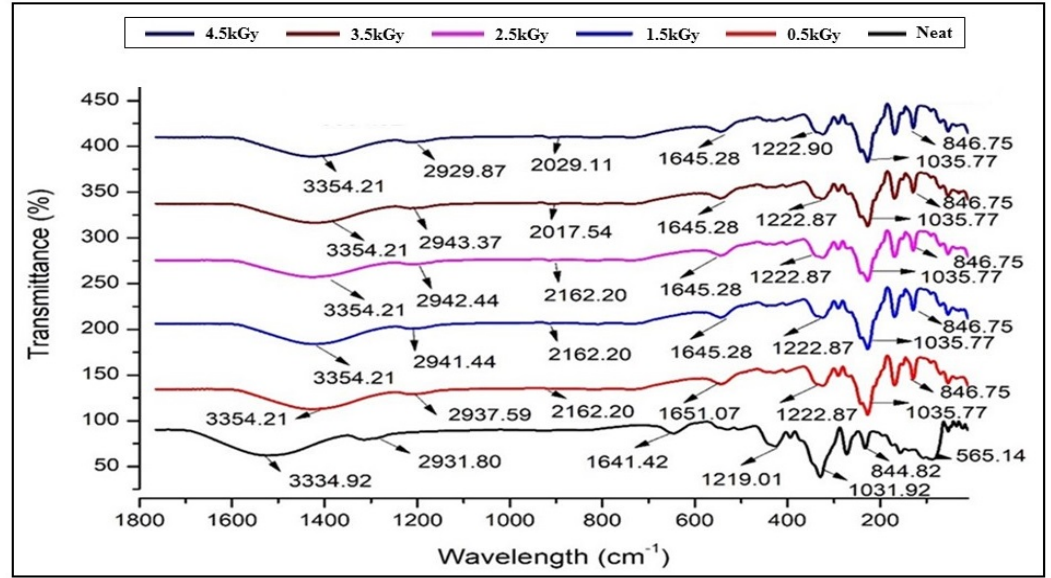
Figure 1. FT-IR spectra of seaweed-neem biocomposite films with different radiation doses (0.5, 1.5, 2.5, 3.5, and 4.5 kGy).